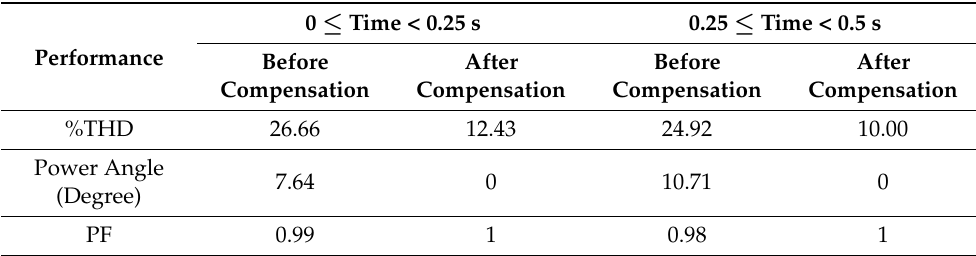
Table 6. The average performance value of ADALINE individual harmonic